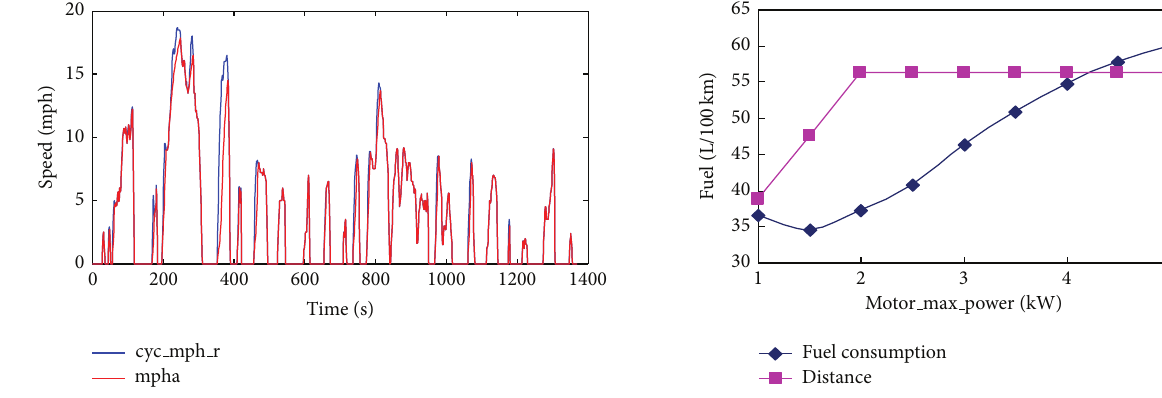
Figure 9: 𝜆 1 = 0.8 , 𝜆 2 = 0.2 , the speed of simulation & drive cycle.